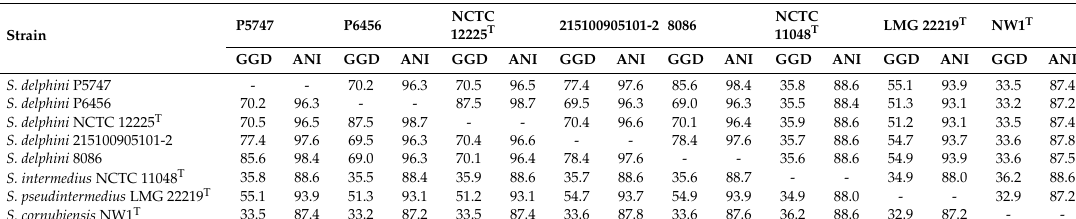
Table 3. Intergenomic distances between the genomes of Staphylococcus intermedius group strains in percent, represented by average nucleotide identity (ANI) and digitally derived genome-to-genome distances (GGD) emulating DNA–DNA hybridization values.